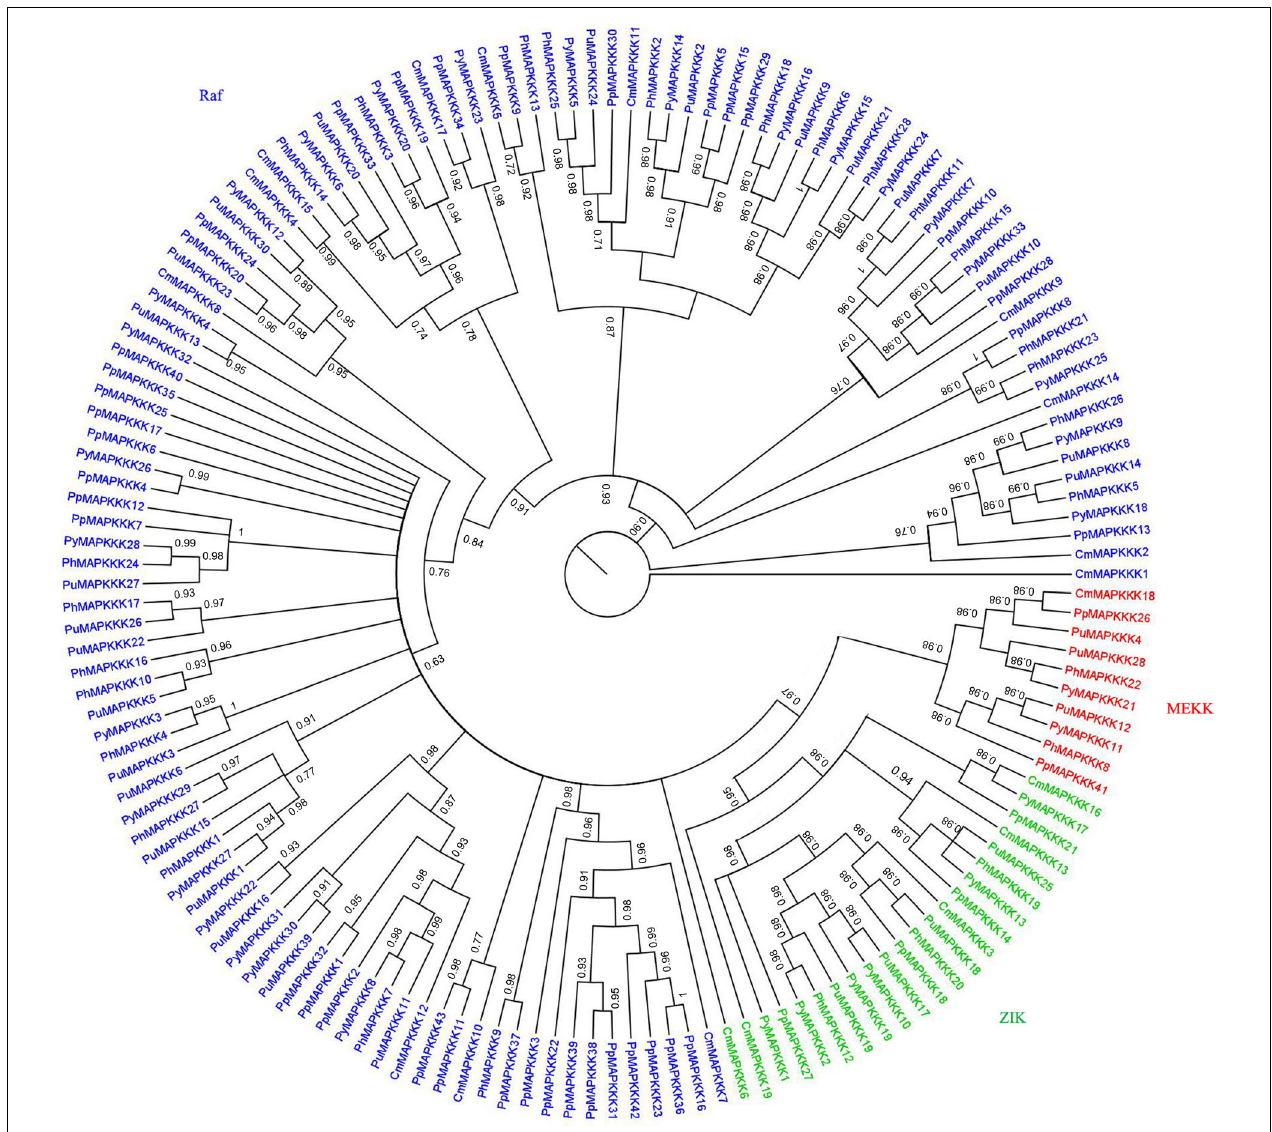
FIGURE 3 | Phylogenetic tree of MAPKKKs from P. yezoensis, C. merolae, P. haitanensis, P. umbilicalis and P. purpureum . Phylogenetic tree was created using bayes_3.2.5, using protein kinase domain of 155 MAPKKK proteins. Red labeled MEKK subfamily, green labeled ZIK subfamily, blue labeled Raf